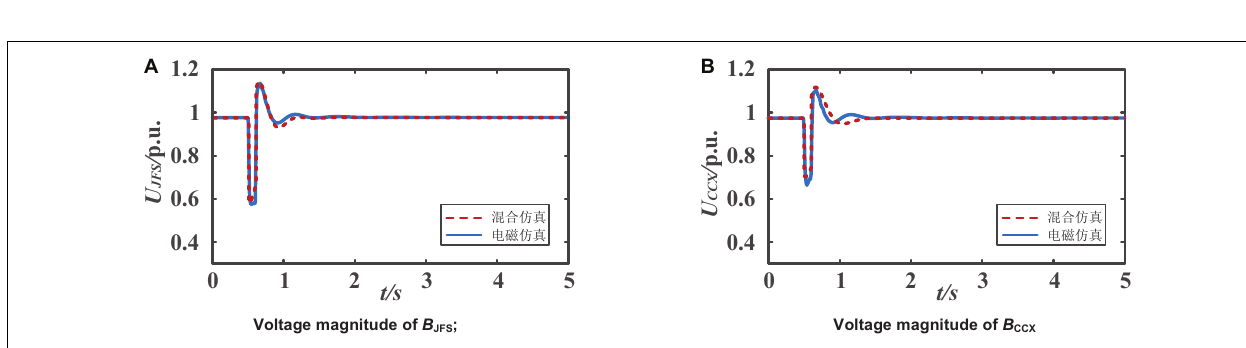
FIGURE 10 | Comparisons of voltage magnitude; (A) Voltage magnitude of B JFS ; (B) Voltage magnitude of B CCX .